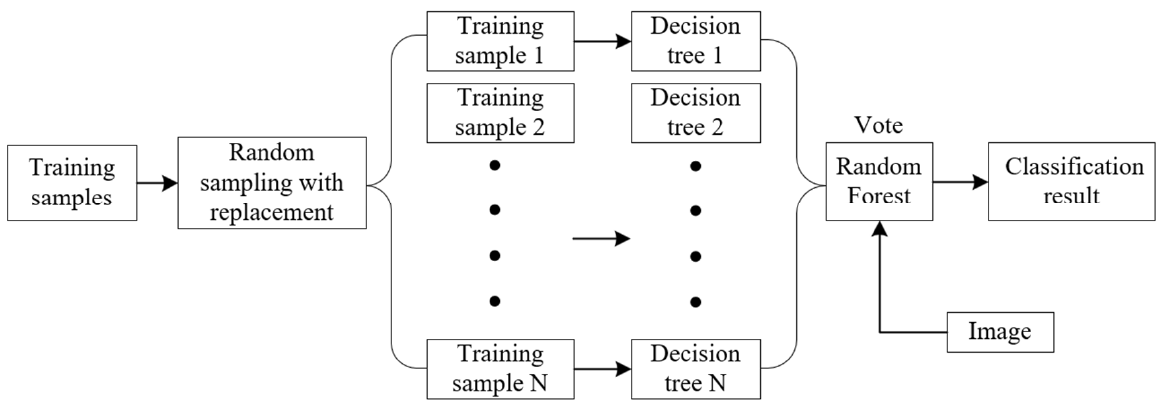
Figure 5. Schematic diagram of Random Forest for classification.